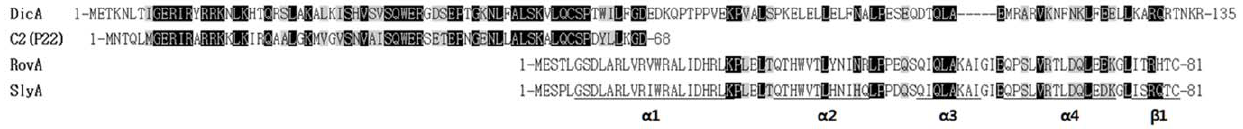
Figure 9. Amino acid alignments of DicA with functionally and structurally homologous proteins. The N-terminal part of DicA lines up well with the N-terminus of the C2 (GenBank: NP_059606.1) protein from the Salmonella phage P22. The C-terminal part of DicA shares significant amino acid sequence homology with the N-termini of RovA (GenBank: AAK01704.1) of Yersinia and SlyA (GenBank: AAL55673.1) of Salmonella . Identical amino acids with DicA are marked in black. The winged helix DNA-binding domain is underlined with the secondary structure labeled. The amino acid sequences are taken from the GenBank database, and the sequence comparison algorithm BLAST [33] was used.